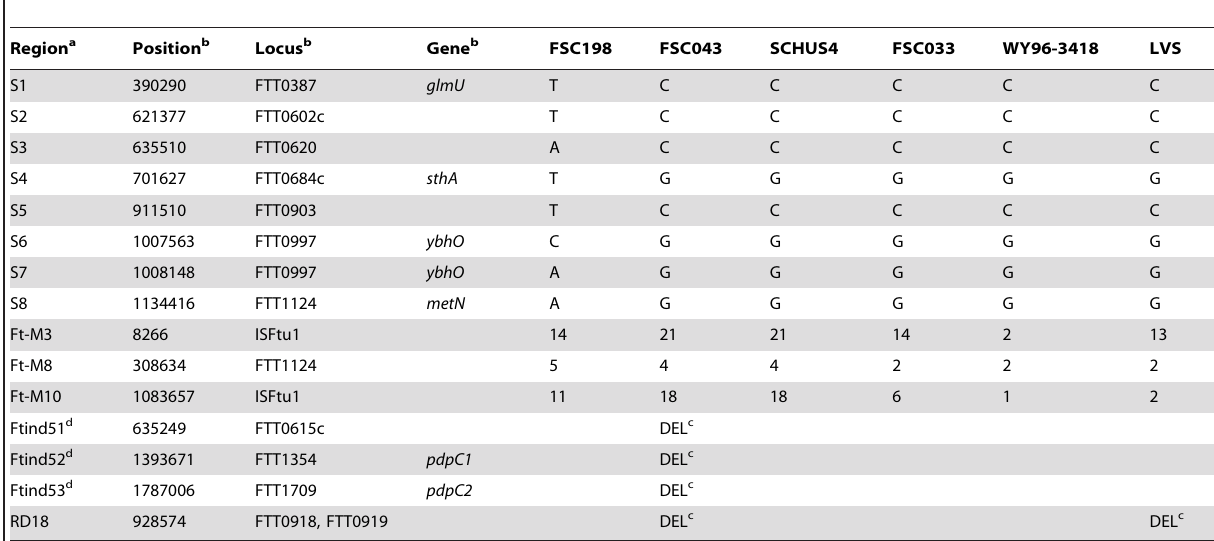
Table 1. Identified SNP, INDEL and VNTR differences between FSC198, FSC043 and SCHU S4 strains and their corresponding regions in three other genomes of F. tularensis .